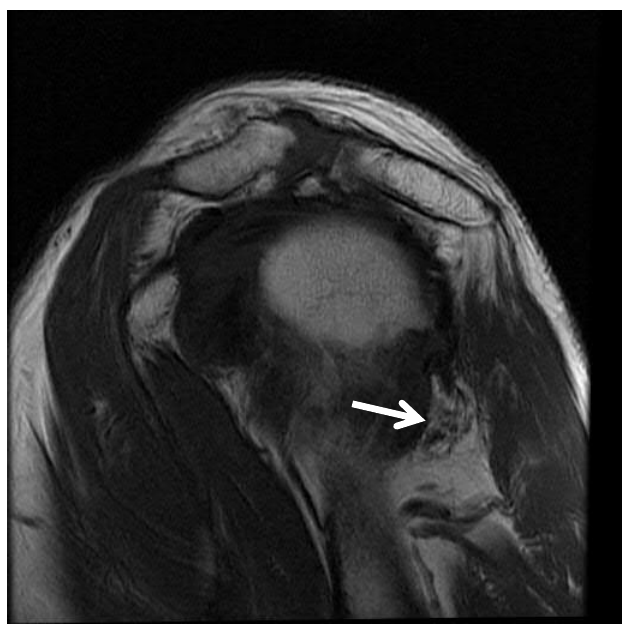
Figure 2. Atrophic left teres minor on magnetic resonance imaging (MRI) of shoulder in patient with quadrilateral space syndrome.